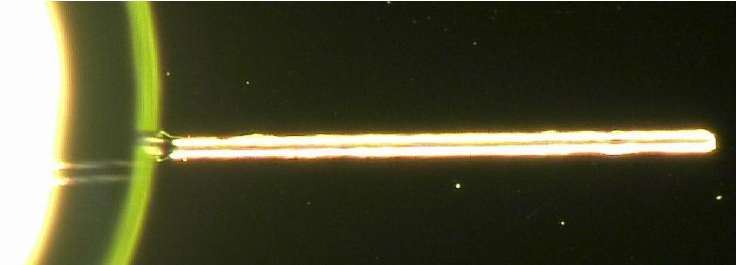
Figure 3. Optical micrograph of a 1,400 µm long liquid protrusion along electrodes without any bumps ( w = 5 µm , g = 6 µm , f = 100 kHz ).